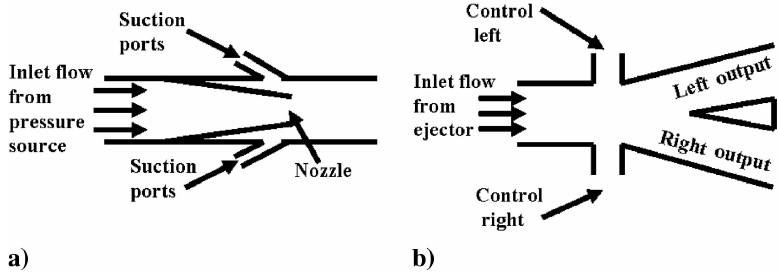
Figure 1. Schematic rendering of the Suction and Oscillatory Blowing (SaOB) actuator: ( a ) Ejector, and ( b ) switching valve (adopted from [18]).